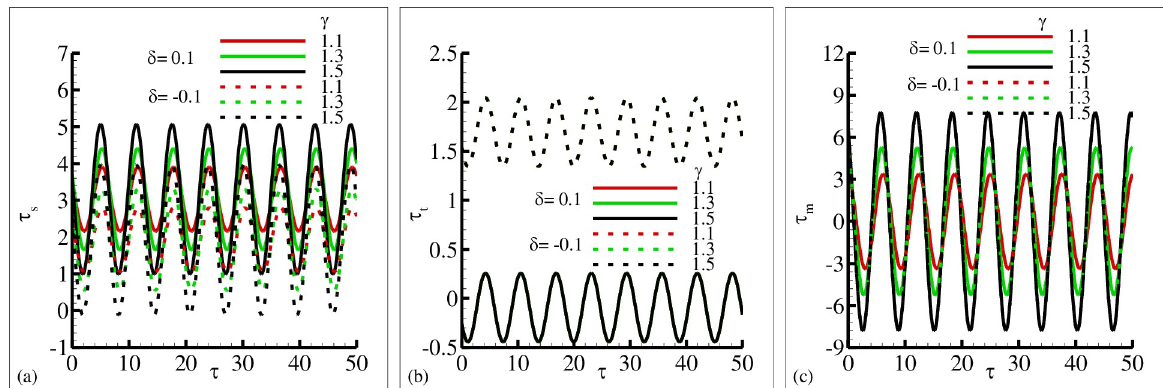
(b) q and (c) j for various values of γ = 1.1, 1.3, 1.5 for heat source δ = 0.1 and sink δ = − 0.1, where other w w w